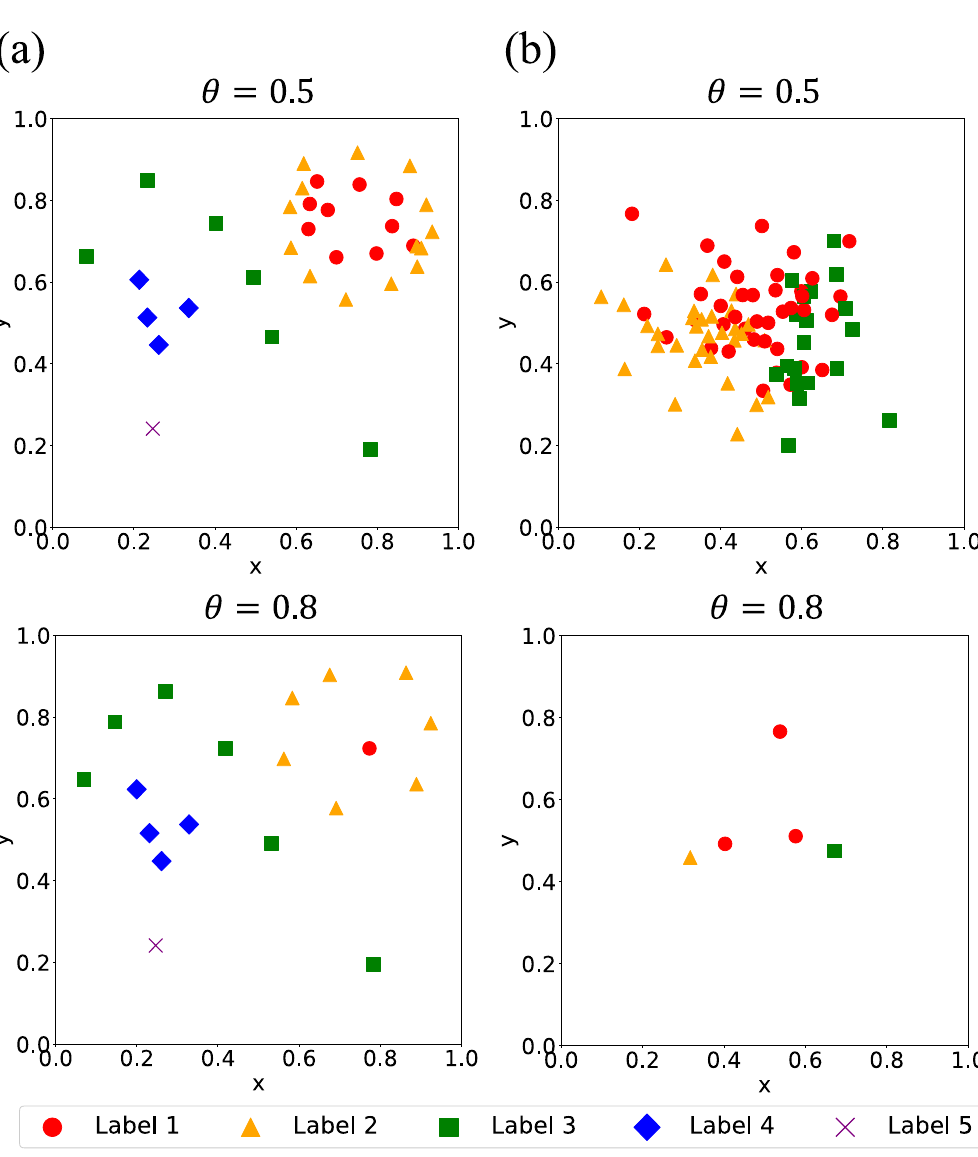
Figure 4. Experiment 3 results. The figure shows results of 1 trial in which SILVQ–LS with confidence threshold θ = 0.5 and 0.8 trained with each dataset 30 times. Points in the figure indicate prototypes corresponding to each label. ( a ) Results for Artificial dataset 1. ( b ) Results for Artificial dataset